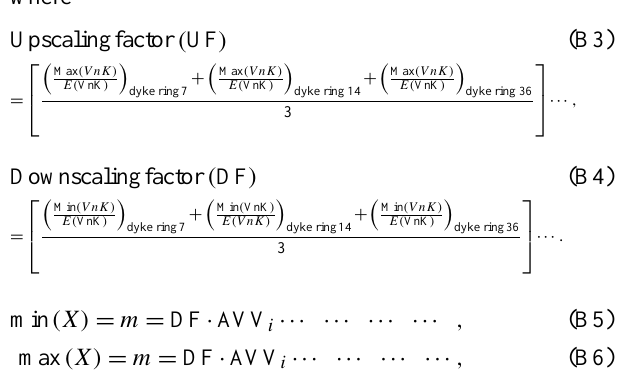
Figure E1: A conceptual sketch of cumulative bounded distribution function